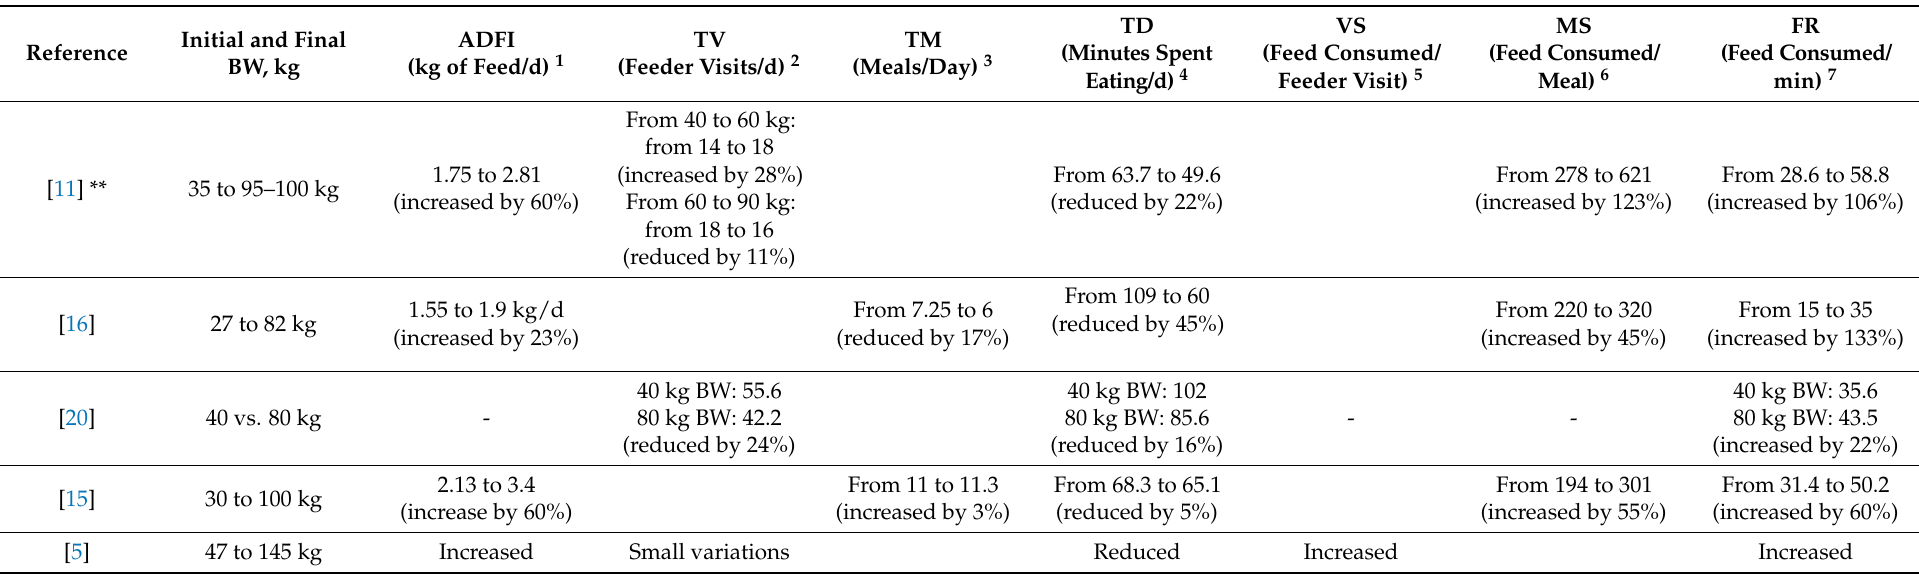
Table 2. Effect of age on the feeding behaviour habits of growing-finishing